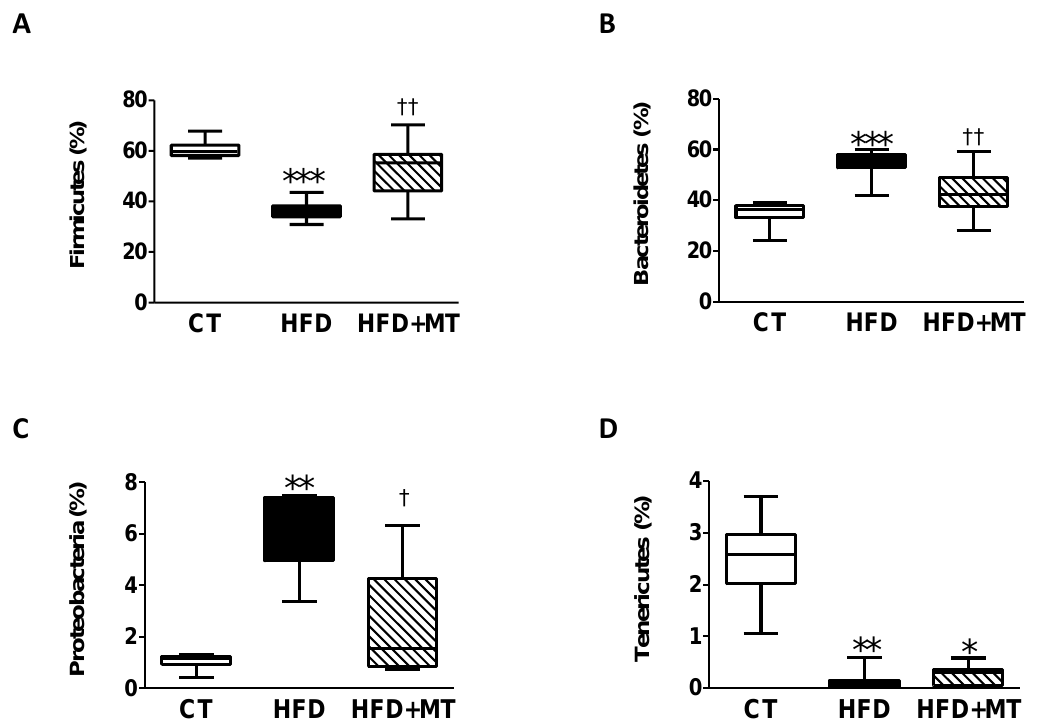
Figure 3. Boxplot showing total relative abundance of reads of the four most abundant taxa at Phylum level in the gut microbiota ( A ) Firmicutes , ( B ) Bacteroidetes , ( C ) Protobacteria and ( D ) Tenericutes in feces from control animals fed a normal chow (CT) and animals fed a high fat diet (HFD) treated with vehicle or with the mitochondrial antioxidant MitoTempo (MT; 0.7 mg / Kg / day i.p). Upper, middle and lower lines represent first quartiles, medians and third quartiles. The whiskers represent a 1.5 * inter-quartile range. Data are expressed as percentage of total reads. * p < 0.05; ** p < 0.01; *** p < 0.001 vs. CT group. † p < 0.05, †† p < 0.01 vs. HFD group.